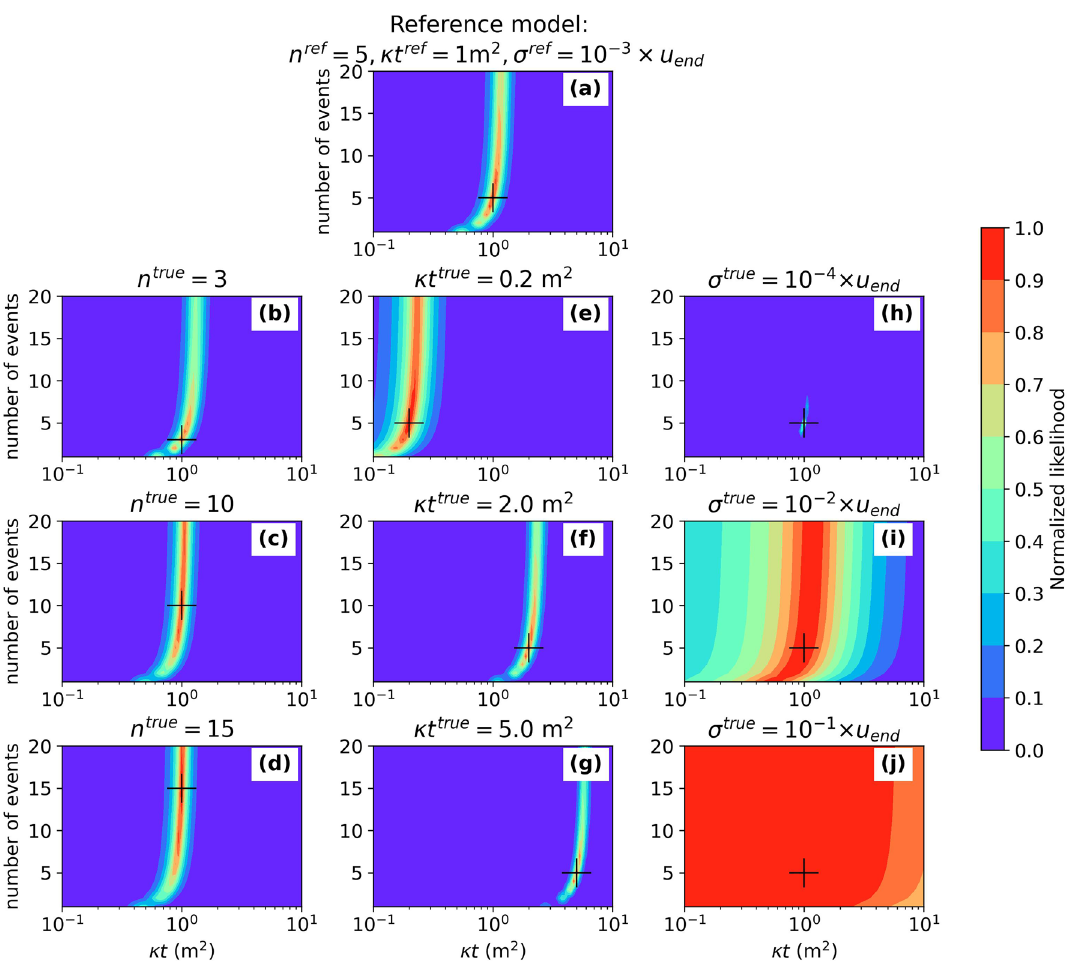
Figure 4. Likelihood distribution associated with synthetic tests. The black cross corresponds to the “true” model parameters. ( a ) Reference model associated with a five-events scenario, a constant κ t u end . ( b – d ) Effect of the number of events with n true ranging from 3 to 15, κ t true noise level of 10 − 3 × σ ref . ( e – g ) Influence of the κ t parameter, with κ t true varying from 0.2 to 5 m 2 , n true and σ true = σ ref . ( h – j ) Sensitivity to the topographic noise, with noise level between 10 and σ true = 1 κ t ref . Figure generated using the Python’s matplotlib 10 u end , n true n ref and κ t true − = × =